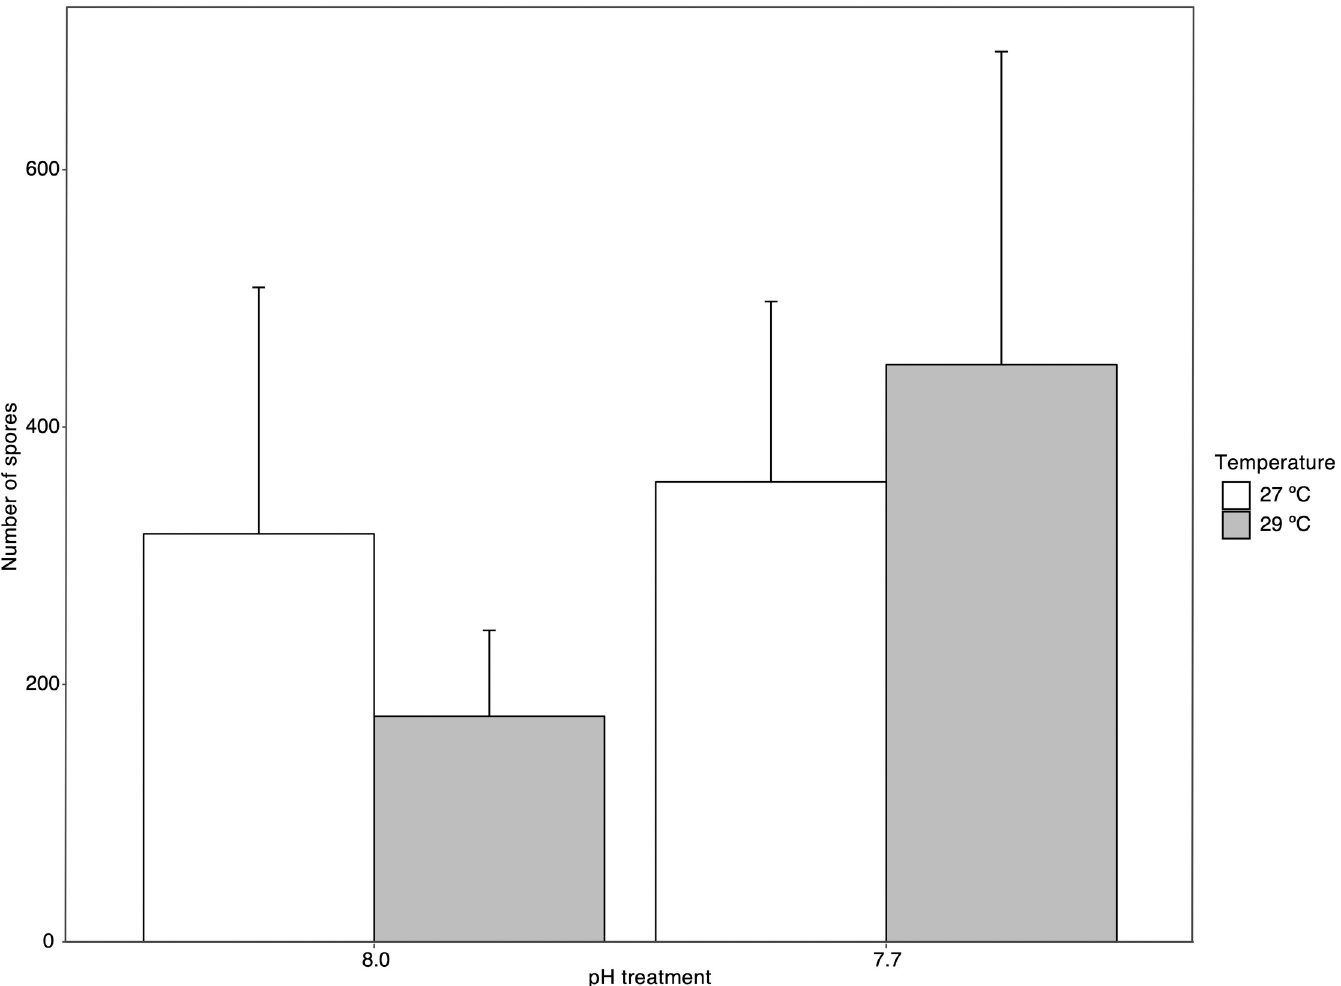
Fig 1. Effects of temperature and p CO 2 (pH) on the reproductive output of adult Sporolithon after one month in treatment conditions. Each bar represents mean number of spores released for each treatment ± SE (standard error) for n = 5–6.